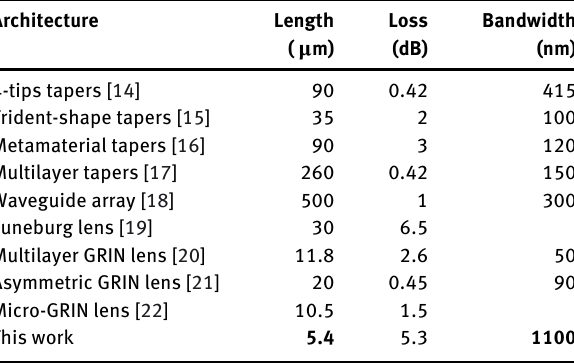
Table 1: Performances of various fiber-to-chip edge